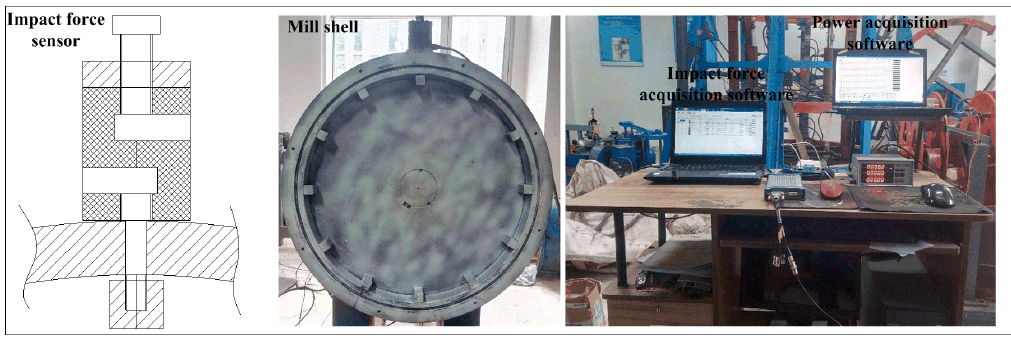
Figure 3. Laboratory-scale mill and data acquiring system.